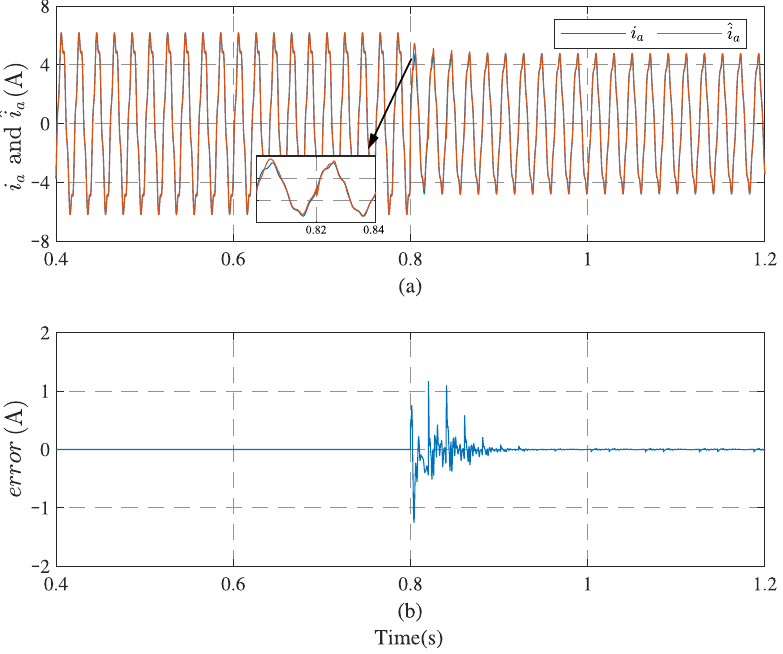
Figure 10. ( a ) Comparison between ˆ i a and i a . ( b ) Error